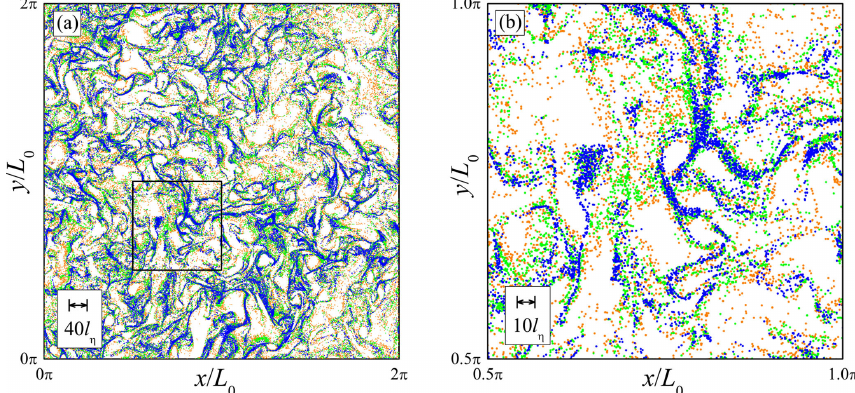
Figure 1. Spatial distribution of droplets for (orange) St = 0 . 2, (green) 0.5, and (blue) 1.0 in the regions of (a) 2 πL 0 × 2 πL 0 and (b) 0 . 5 πL 0 × 0 . 5 πL 0 . Droplets located in the range of 0 < z < 4 l η are shown. The square frame in (a) corresponds to the region of (b) .